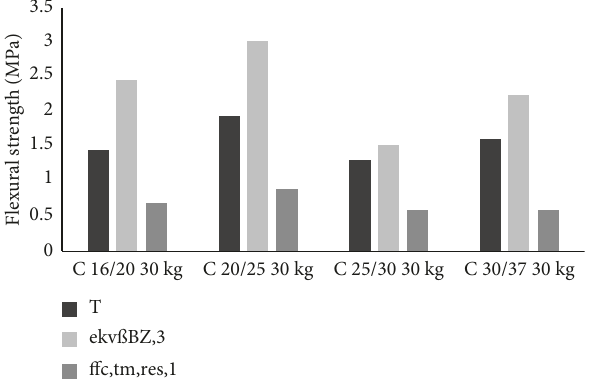
Figure 7: Residual tensile strengths in bending at the moment of achieving a deflection of 3.5mm, steel fiber reinforced concrete with a mass dose of 20kg/m 3 .